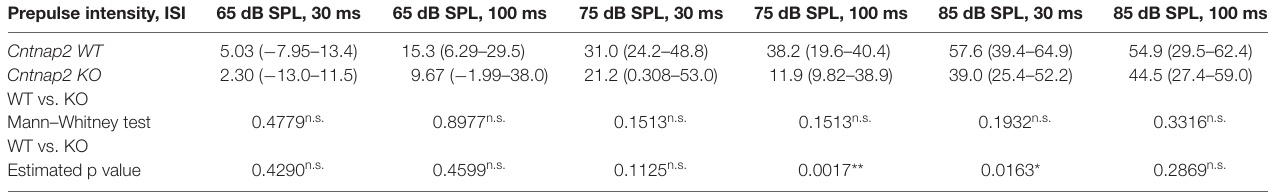
TABLE 5 | Statistical comparison and estimated p values through resampling of %PPI elicited by six prepulse conditions in Cntnap2 WT and KO rats after injection of saline. Prepulse intensity, ISI